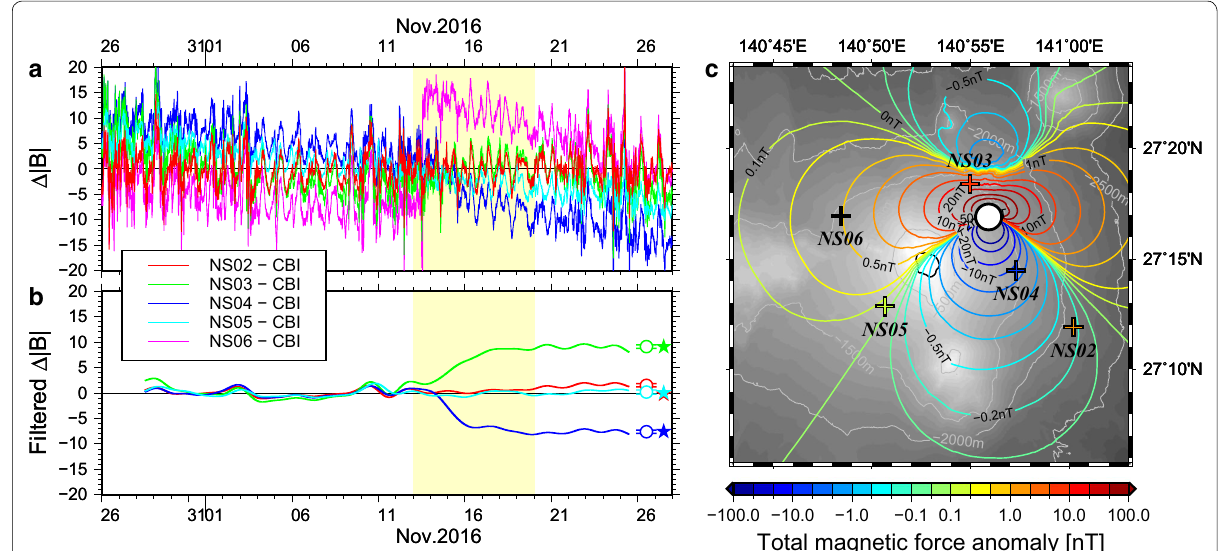
Fig. 4 a Time variation of the residual total magnetic force of each OBEM site to CBI magnetic observatory. Yellow shade indicates Period A. b Same as a , but the data are filtered to reduce the shorter period fluctuations and linear trends. NS06–CBI is omitted in the plot because the NS06 data show a jump. The circles with error bars indicate the average and standard deviation of the data after Period A. Stars are the values predicted by the best fit point-source demagnetization model. c The total magnetic force anomaly distribution (colored contour lines) on the seafloor predicted using the best fit demagnetization source. Note that the contour lines are not drawn at an equal interval but are shown for the values, 0, 0.1, 0.2, 0.5, 1, 2, 5, 10, 20, 50, and 100 nT. Crosses with labels denote the site location and their color except for NS06 ± ± ± ± ± ± ± ± ± ± indicates the observed total magnetic force change. The white circle denotes the horizontal location of the best fit dipole moment, whose radius corresponds to that of the equivalent demagnetization sphere (1.1 km). The background gray shade is the bathymetry map. The black line indicates the island